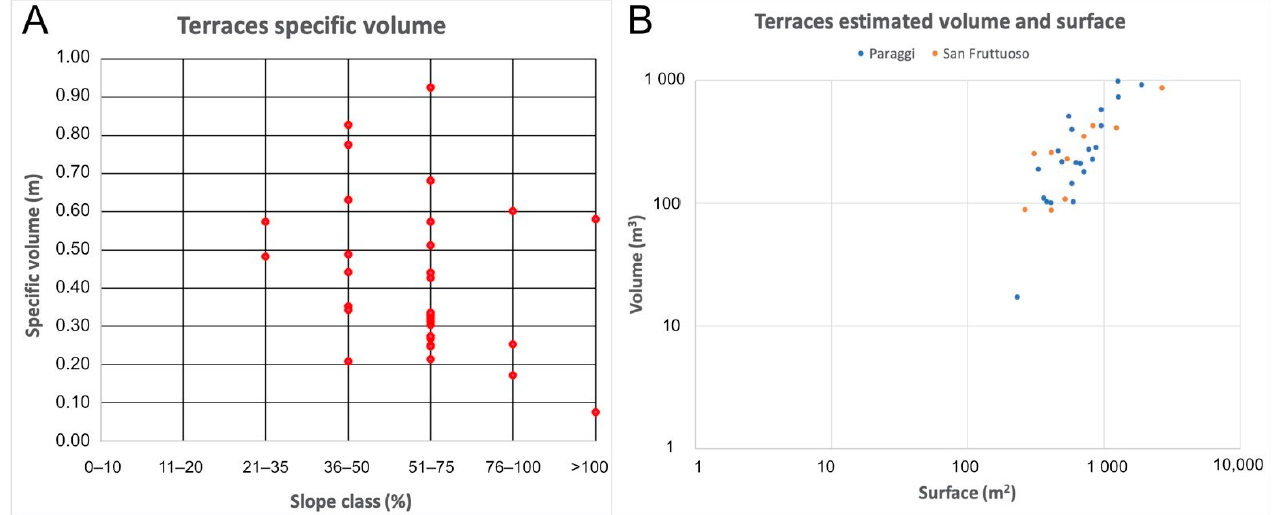
Figure 11. ( A ): Terraces’ specific volume and slope class (for slope classes, refer to Figure 1) for the 32 sample areas. ( B ): The relationship between total volume and surface of the sample areas.